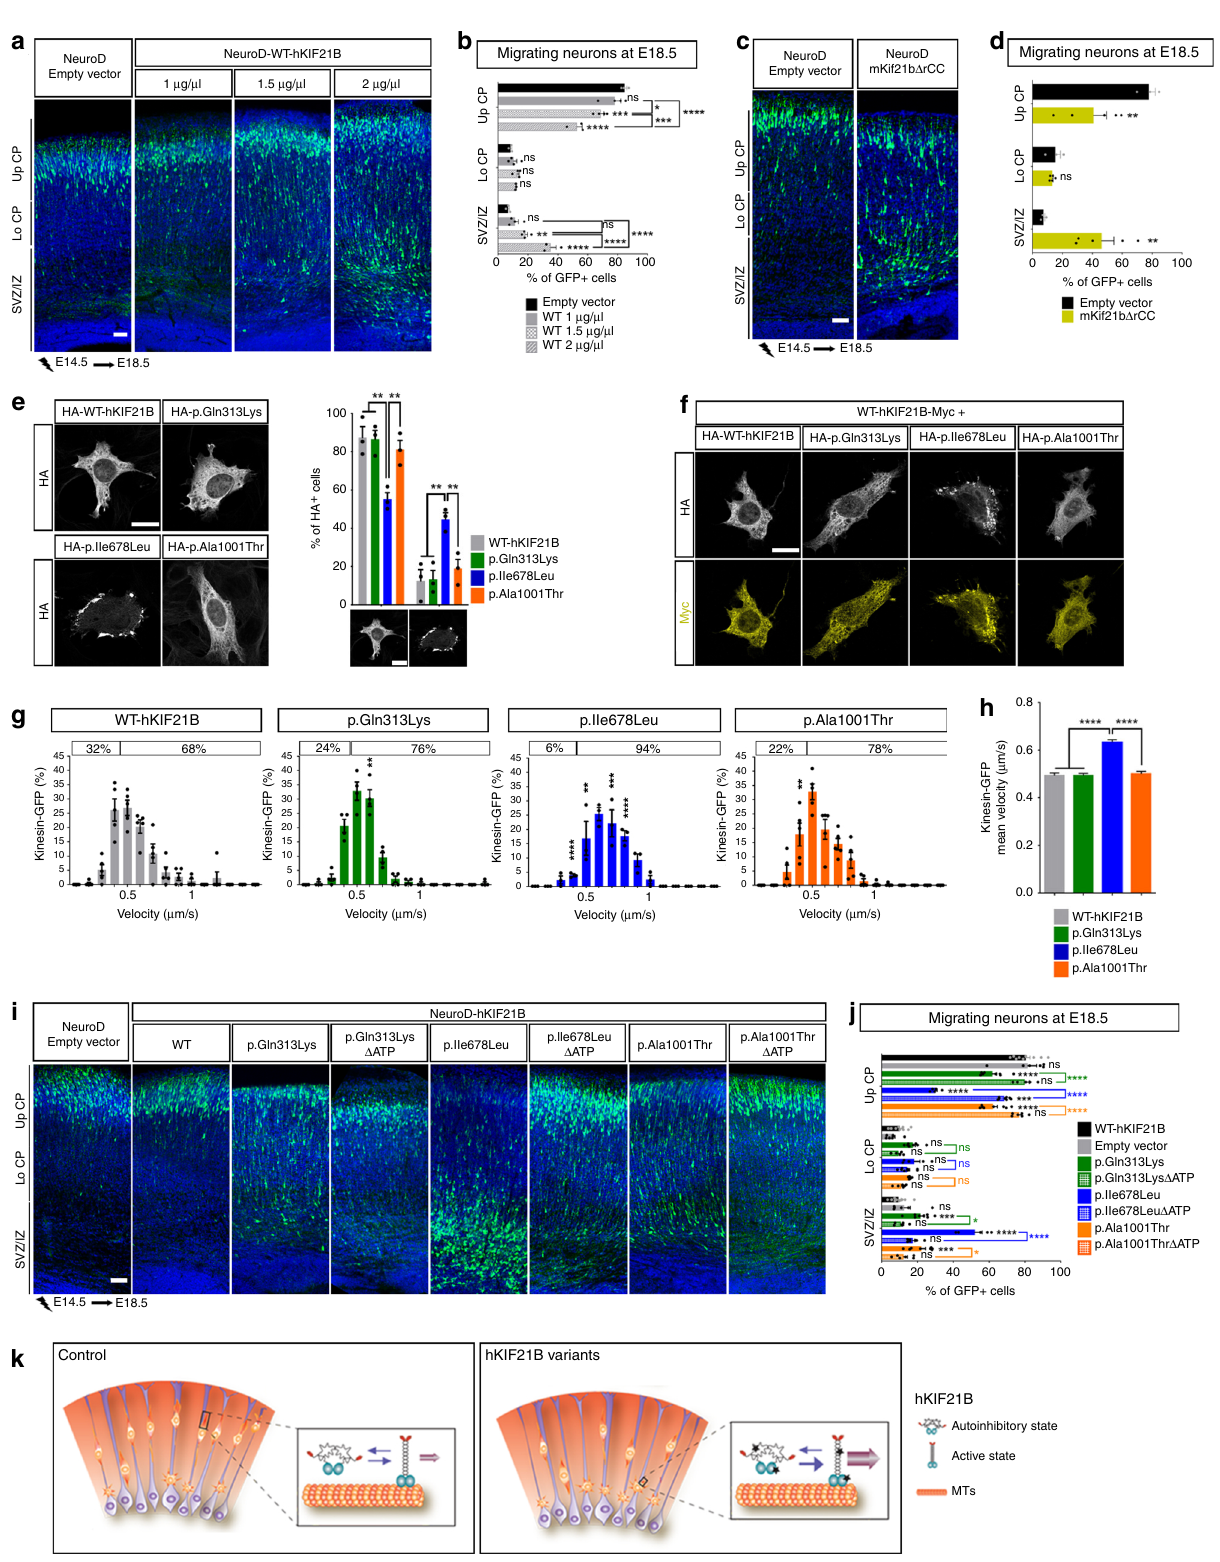
and the three missense mutant proteins in ST cells transfected with pcDNA-HA-hKIF21B cDNA constructs (Fig. 4e, Supple- mentary Fig. 4a). Although WT, p.Gln313Lys and p.Ala1001Thr proteins showed similar diffuse cytoplasmic localization, the p.